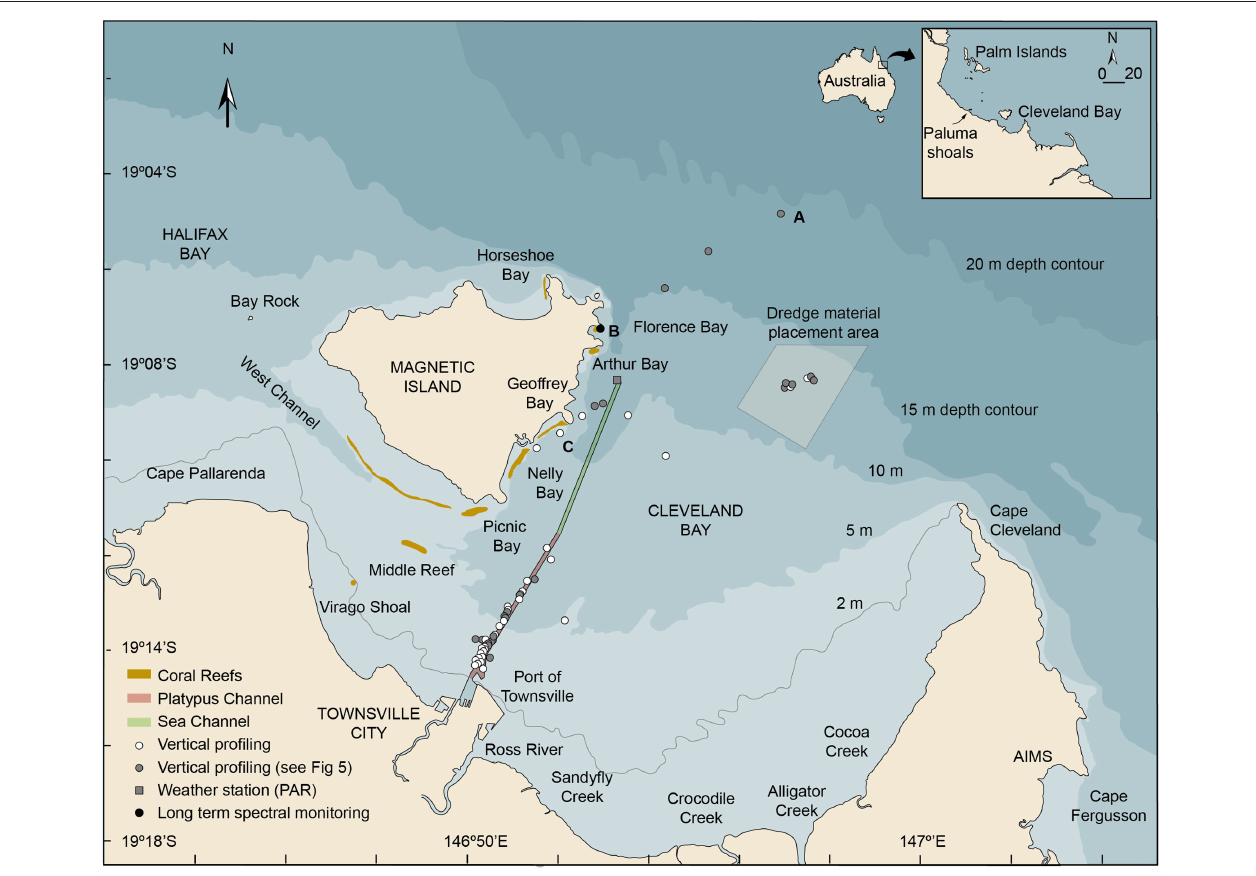
FIGURE 1 | Location map showing Cleveland Bay and Magnetic Island off the coastal city of Townsville in the inner central Great Barrier Reef (Australia) showing the locations of (a) the multispectral light logger deployment in Florence Bay (19.121917 ◦ , 146.883167 ◦ ), (b) the vertical light and turbidity profiling sites conducted beside the shipping channel, the reefs off Magnetic Island, in the dredge material placement area (DMPA), and seaward of the 15m isobath, (c) the Cleveland Bay weather station (-19.140556 ◦ 146.889537 ◦ ) where above water PAR levels were recorded (AIMS, 2020). The inset figure shows the location of Cleveland Bay in the inner central Great Barrier Reef (GBR) region and coral collection sites near the Palm